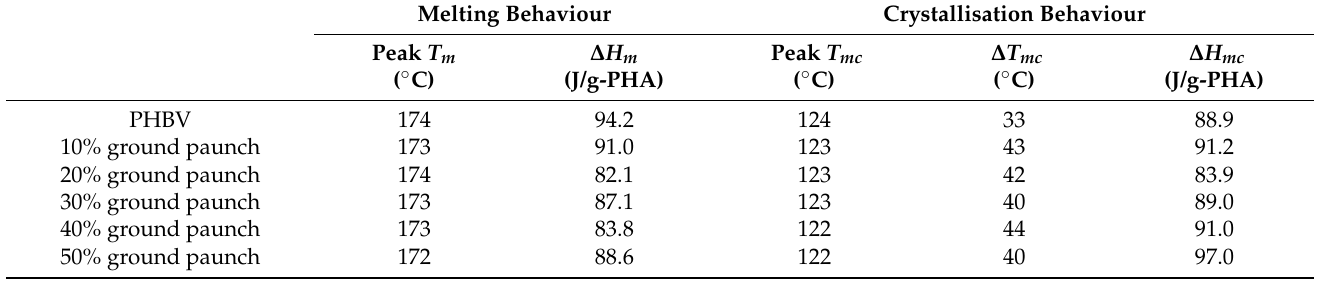
Table 2. Thermal properties for PHBV in PHBV/ground paunch composites, at fibre contents from 0 to 50 wt%, at increments of 10 wt%.